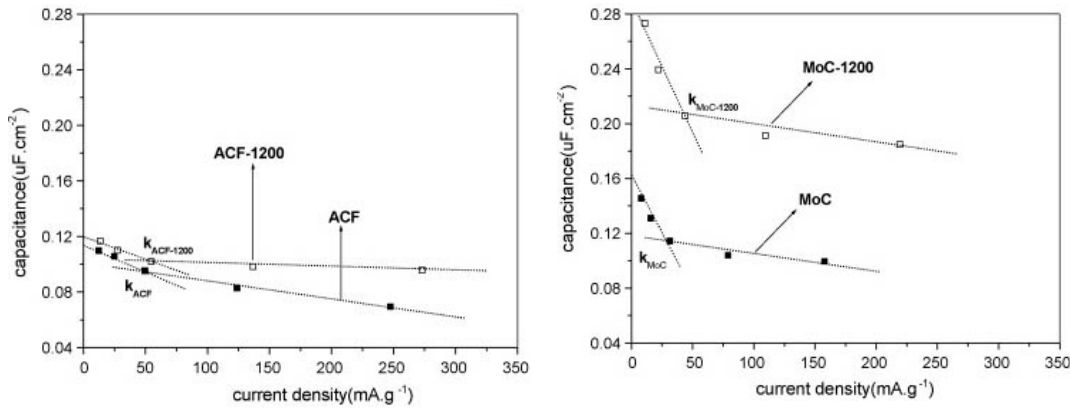
Figure 22. Rate capability of as-received and heat-treated porous carbons of different pore size distribution: ACF—69% of mesopores, MoC—87% of mesopores. 30% KOH as an electrolyte. Reproduced from [167] with permission from Elsevier © 2008.